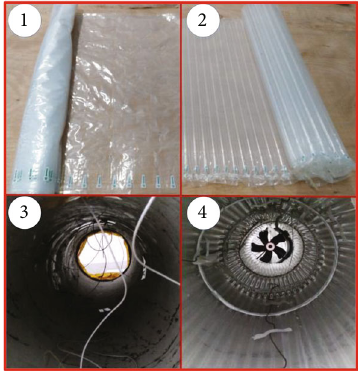
Figure 2: Manufacturing process of the insulation layer for the energy